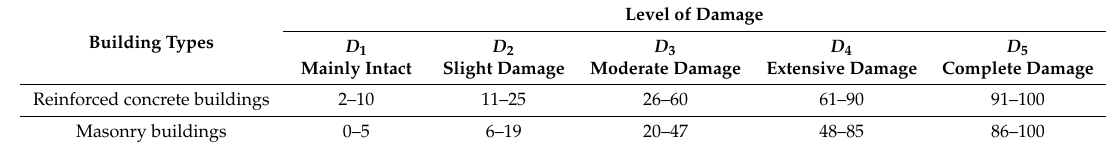
Table 6. Value ranges for the direct economic loss ratios of indoor property in di ff erent structure types (unit: %).